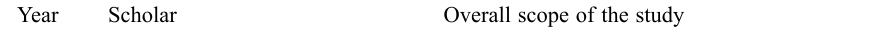
Table 1. Literature review of disruption management in supply chain as a whole Overall scope of the